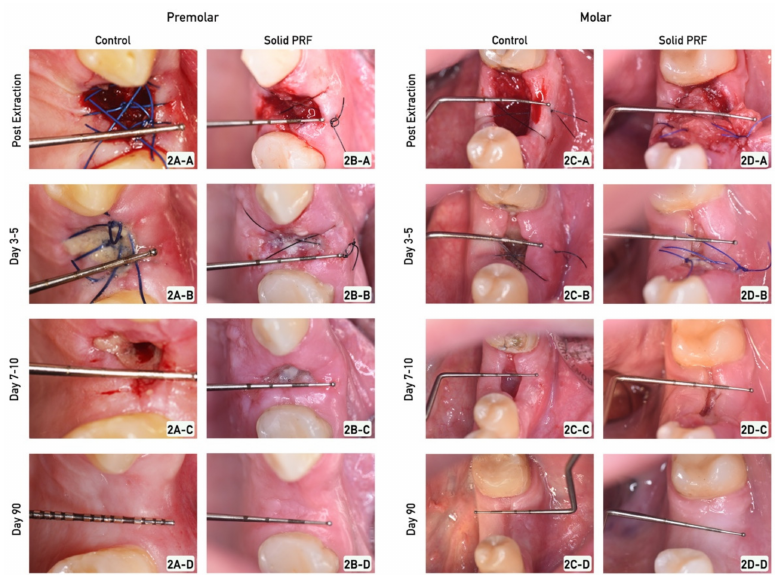
Figure 2. Wound healing progression. Representative images of wound healing progression post tooth extraction and at days 3–5, 7–10, and 90. Left panel represents representative cases for premolars (control group ( 2A ), solid PRF group ( 2B )), and right panel for molars (control group ( 2C ), solid PRF group ( 2D